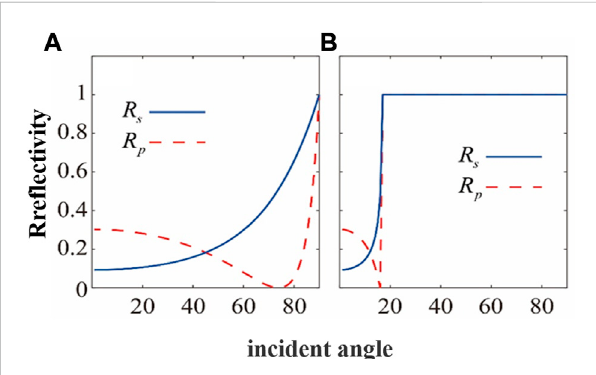
FIGURE 3 There fl ectivityofS-lightandP-light (A) incidentfromairtohigh- resistivity silicon and (B) incident from high-resistivity silicon to air.